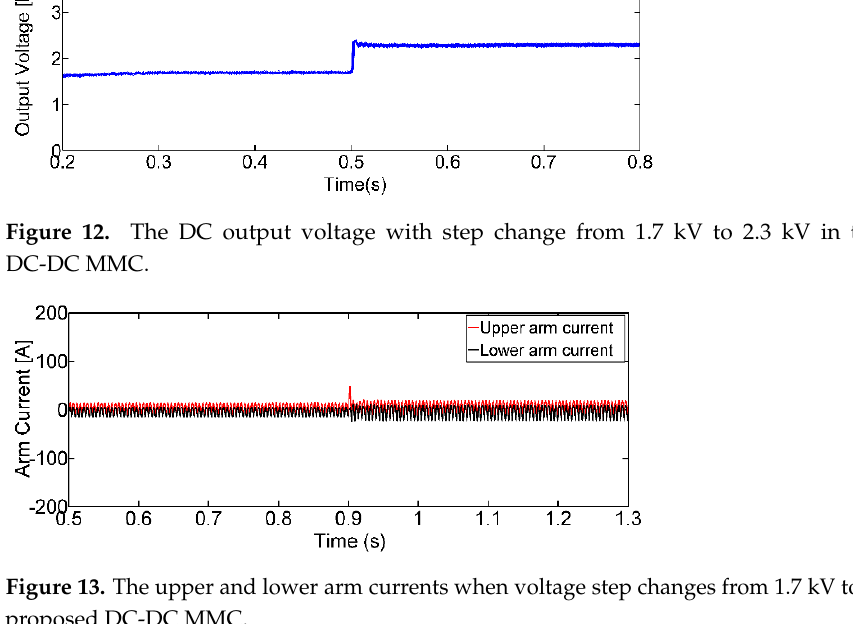
Figure 13. The upper and lower arm currents when voltage step changes from 1.7 kV to 2.3 kV in the proposed DC-DC MMC.